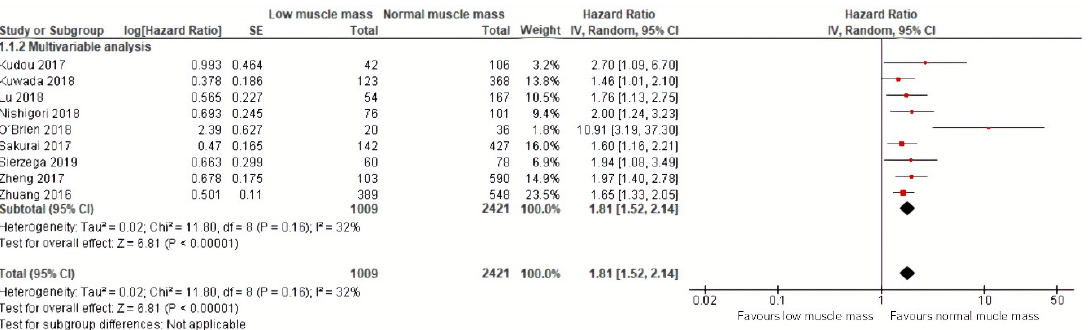
Figure4. Forestplotsofunivariableandmultivariableoddsratiosforseverepostoperativecomplications for gastric cancer patients with low muscle mass versus normal muscle mass.